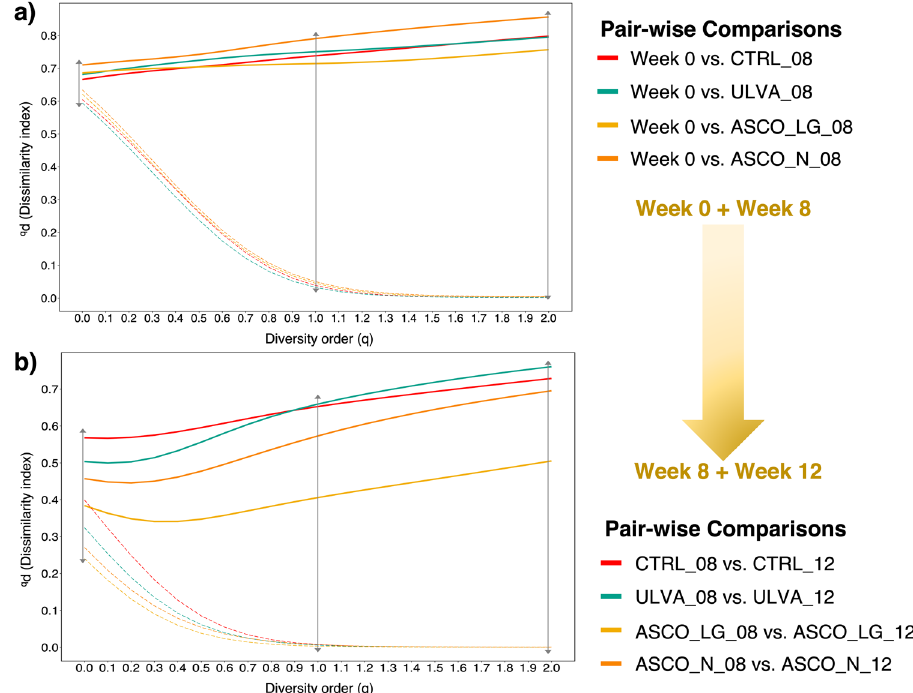
Fig. 2 Microbial community assembly in the gut microbiota of Atlantic cod. The presence/absence of OTUs from Week 0 to Week 8 and Week 8 to Week 12 treatments are shaped by random microbial community assembly (at q = 0; empirical values are close to the null expectation). When we increase the importance of OTU relative abundance then assembly is shaped by deterministic processes (q ≥ 1; empirical values far greater than the null expectation). The solid lines show hill-based dissimilarity (qd) and the null expectation is shown by dashed lines. The diversity order (q) curve can be interpreted as follows; q = 0 considers OTU presence/absence, q = 1 OTUs are weighted according to relative abundance, and at q > 1 = increased weighting is given to highly abundant OTUs. Arrows at q = 0, 1, and 2 re fl ect the distances between the empirical dissimilarity observations and the null expectation at these key points in the diversity order curve (q). Colours re fl ect the pair-wise comparison tested. a shows comparisons between Week 0 and Week 8, and b shows comparisons between Week 8 and Week